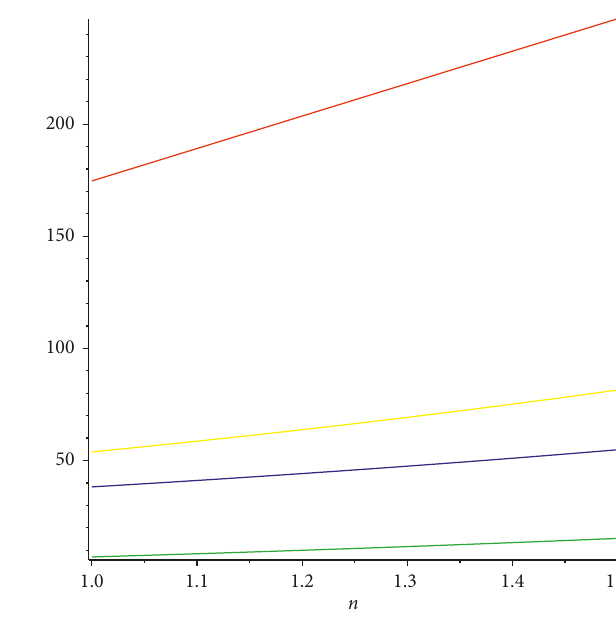
P n n , PETIM, DPZ n , and PETAA.